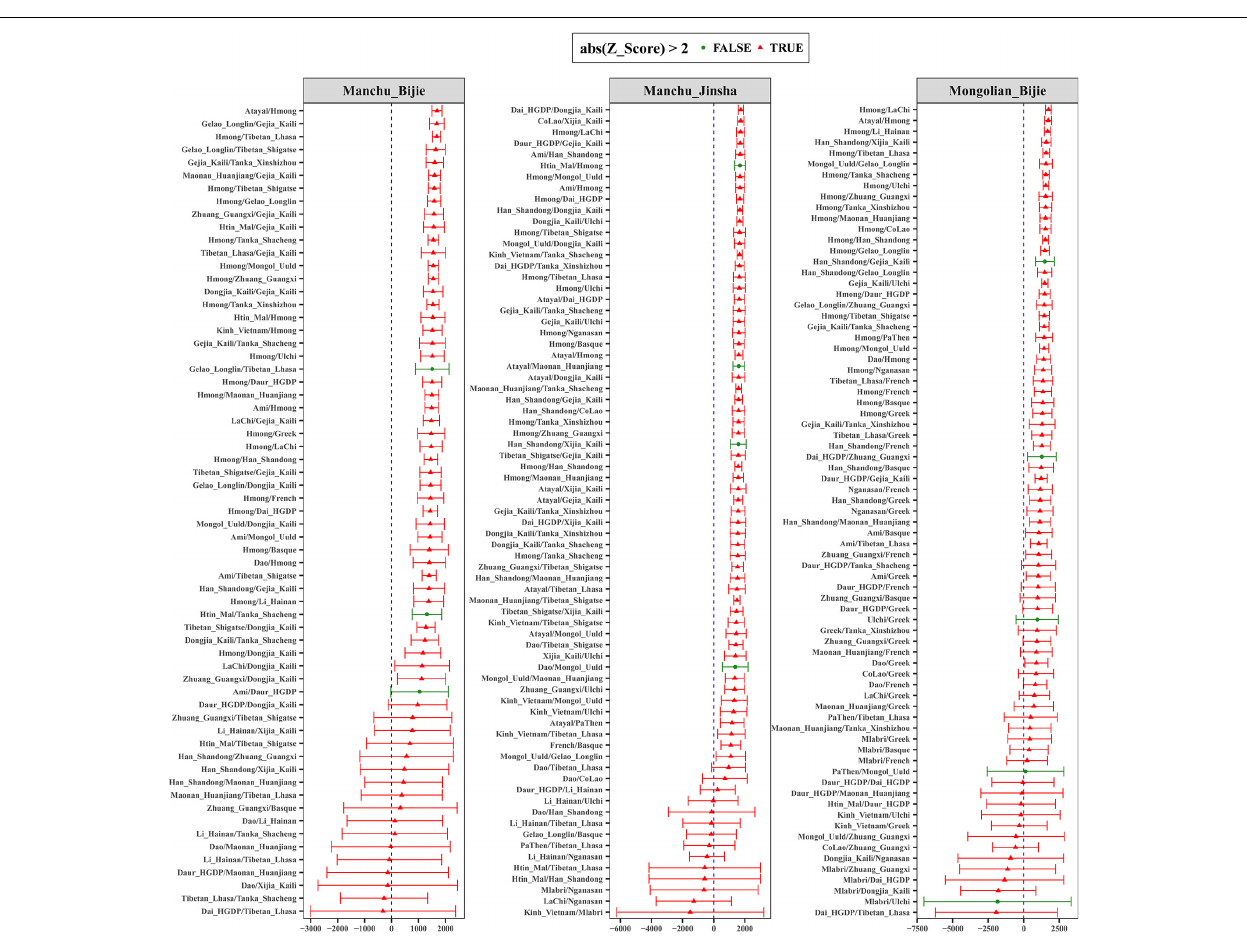
Frontiers in Genetics |